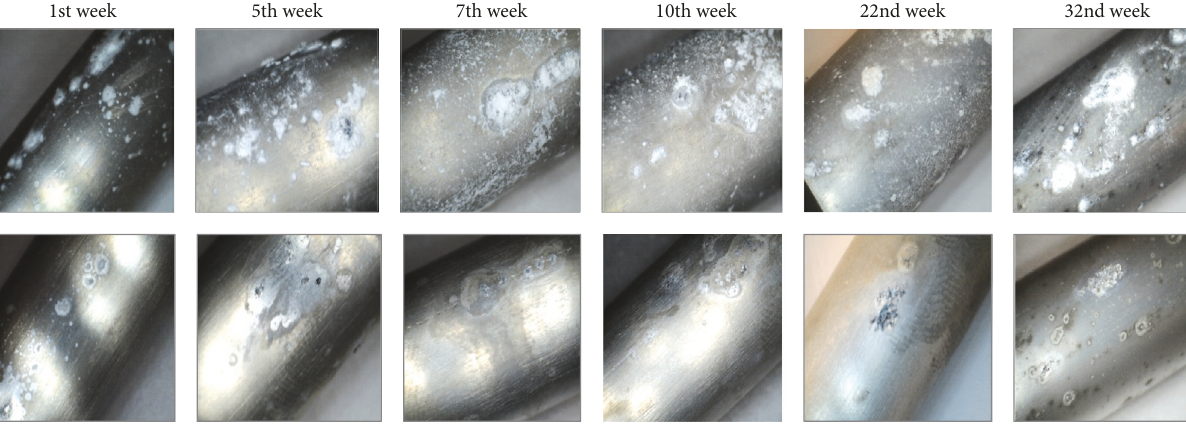
Figure 5: Visual images of Al 6061 specimens after immersion in the Red Sea water at different time